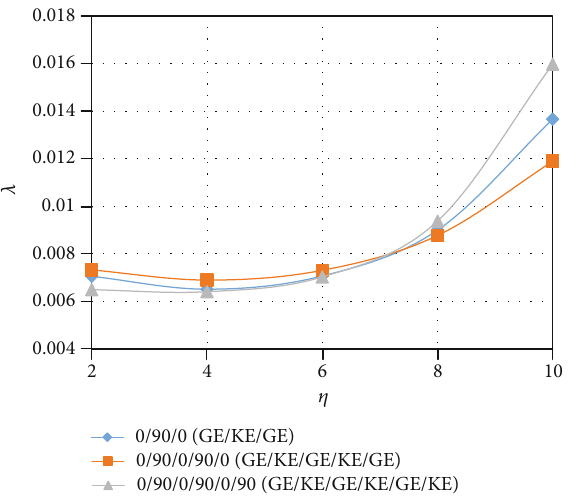
Figure 10: Variation of angular frequency and circumferential node number of 3-, 5-, and 6-layered annular circular plates. S-S.